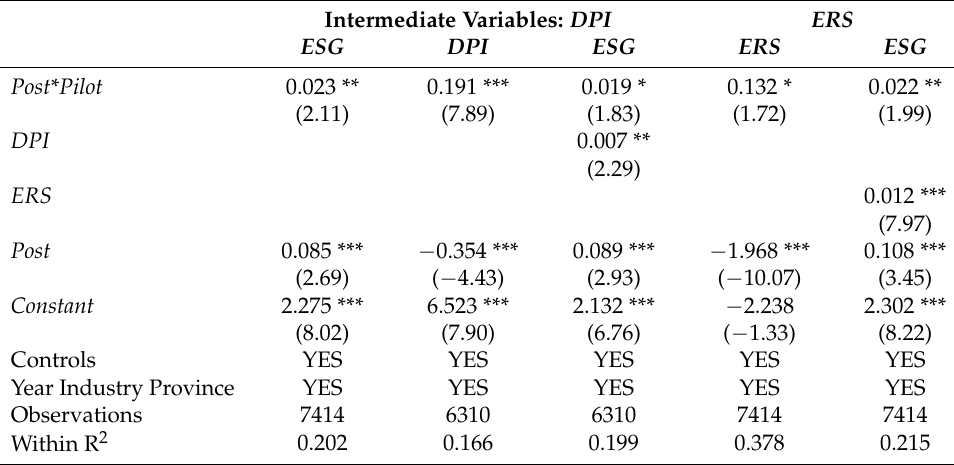
Table 4. Environmental mechanism: DPI and ERS